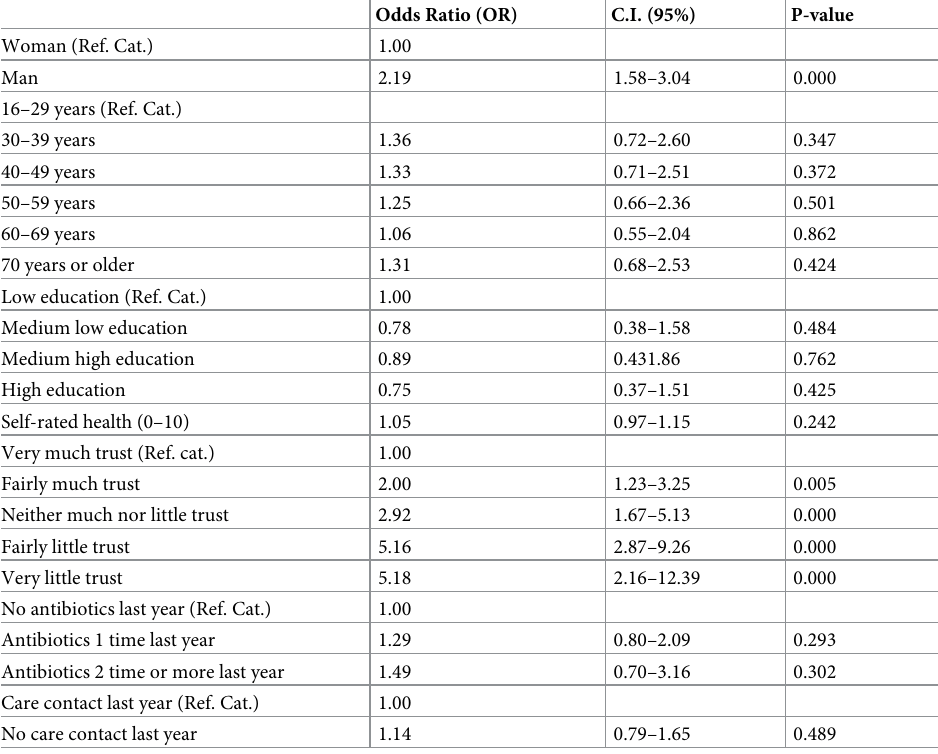
Table 4. Likelihood of future non-prescription acquisition of antibiotics, according to demographic variables, self-rated health, trust in health care, antibiotic use and health care contacts. Odds ratios (OR), 95 confidence intervals (95% CI) and p-values (n = 4 195). Odds Ratio (OR) C.I. (95%) Woman (Ref.